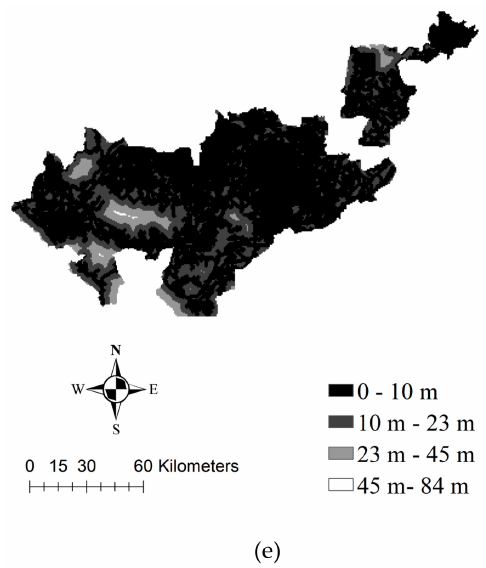
Figure 3. Criteria for the land suitability analysis for extension of potential forest areas. ( a ) Settlements,